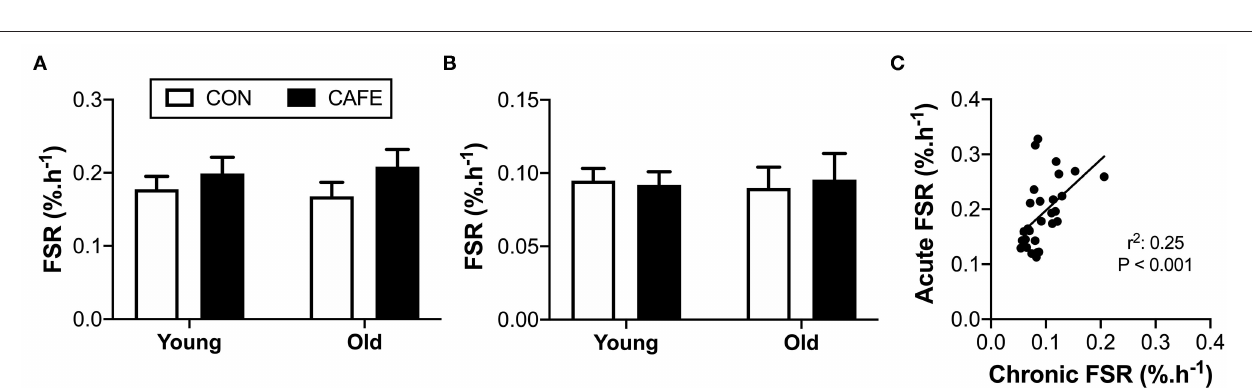
FIGURE 4 | Effect of 12-week cafeteria diet on mixed-muscle protein fractional synthetic rate in young and old Brown Norway rats. Mixed-muscle protein fractional synthetic rate assessed (A) acutely following an oral leucine bolus, performed under hyperinsulinemic conditions, and (B) chronically, performed over a two-week period. Values represent means ± SEM. No significant differences observed between groups. (C) Relationship between acute and chronic measures of mixed muscle protein synthetic rate, performed using two alternative stable-isotope labelling methodologies. Significant correlation between acute and chronic measures of mixed muscle protein fractional synthetic rate observed ( P < 0.001). n =